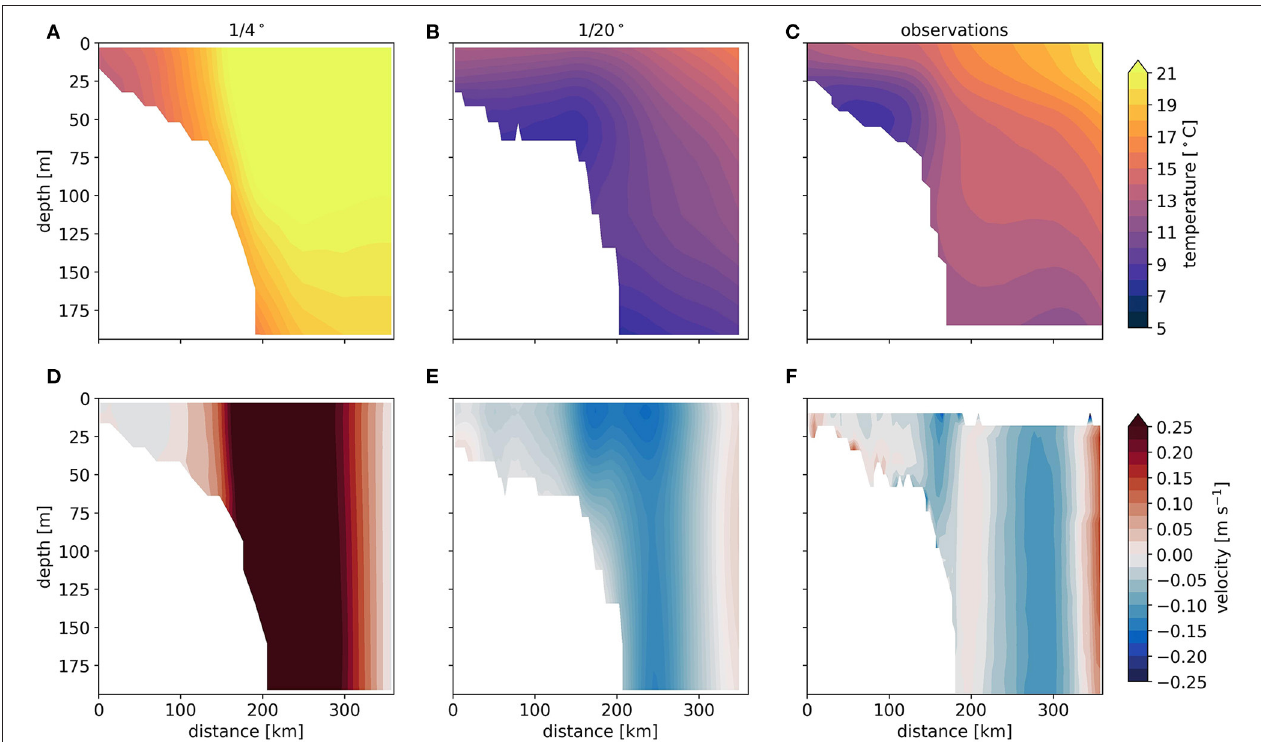
FIGURE 3 | Subsurface validation; mean temperatures (A–C) and along shelf velocities (D–F) for ORCA025 (A,D) , VIKING20X (B,E) , and Observations from the Oleander Line (C,F) for the overlapping data periods from 1982–2016 to 1994–2018, respectively; velocities are positive in the north-east-direction, distance starts at Ambrose Lighthouse in New York